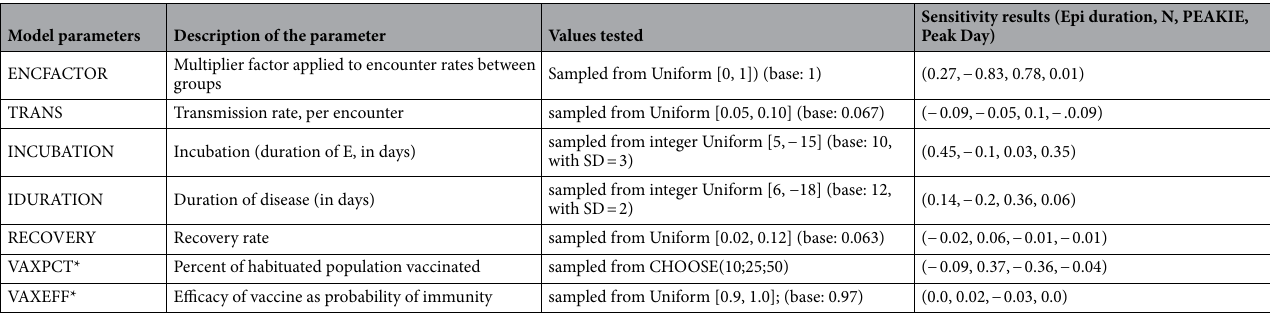
Table 4. Model parameters varied in sensitivity analyses of effects on the severity and timing of a simulated Ebola virus outbreak. All parameters were varied independently and simultaneously in 10,000 iterations of one scenario that did not include vaccination (results for the first five disease parameters) and of one scenario that included preemptive vaccination of 50% of the gorillas in habituated groups (results shown for the last two vaccination parameters). R 2 was calculated for the duration of the epidemic (Epiduration), total number of individuals alive at the end of the simulation (N), the number of highest cases in a single day (peak IE), and the day with the highest number of cases (peak day). *Only used in vaccination